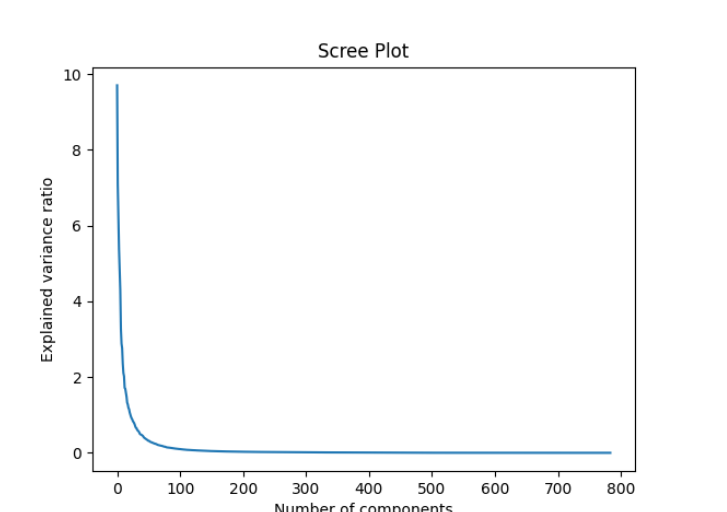
Figure 6a – Scree plot of the explained variance ratio for each component Рис. 6a – График осыпи объясненной дисперсии ро каждому компоненту